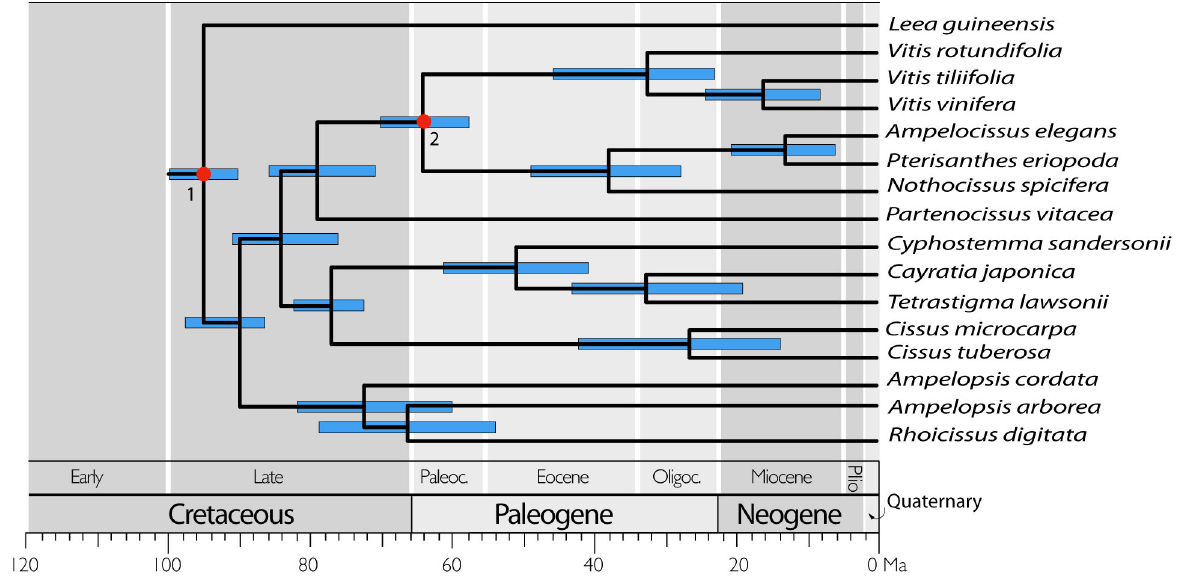
Figure 4. Divergence time estimation of Vitaceae clades using the program mcmctree in PAML and 4-fold degenerate sites. The red dots correspond to calibration points.